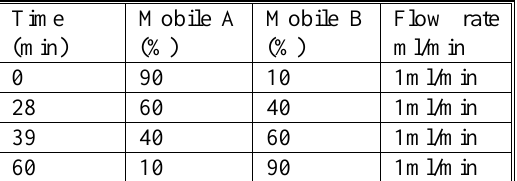
Table 2.The gradient program used in separation by HPLC system.